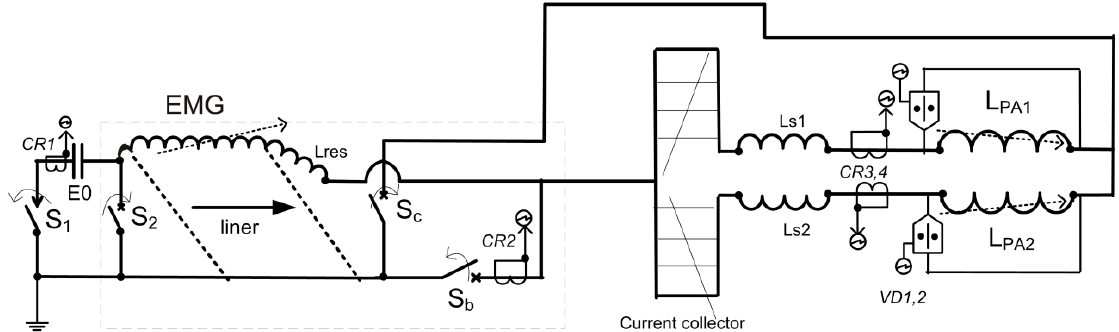
Figure 7. Schematic diagram of the connection of the pulse-current source–EMG load in the form of two PPA connected in parallel. L PA 1 , L PA 2 and L s 1 , L s 2 —inductances of PPA1, PPA2, and parasitic inductances, respectively; E 0 is the initial source of energy, S —contactors: S c —solid-state closer